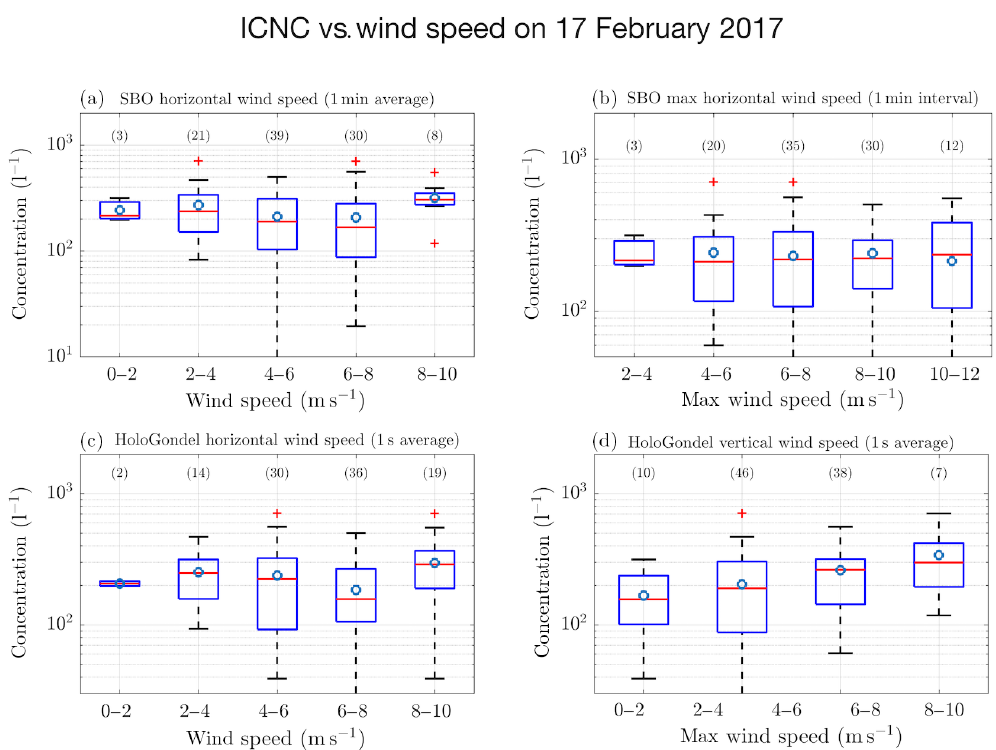
Figure 11. As Fig. 9, but only for 17 February and four different wind speed measurements: (a) 1min averages of the horizontal wind speed from the SBO, (b) maximum wind speed of the corresponding time interval in (a) , (c) 1s averages of the horizontal wind speed and (d) 1s average of the vertical wind speed from both 3-D sonic